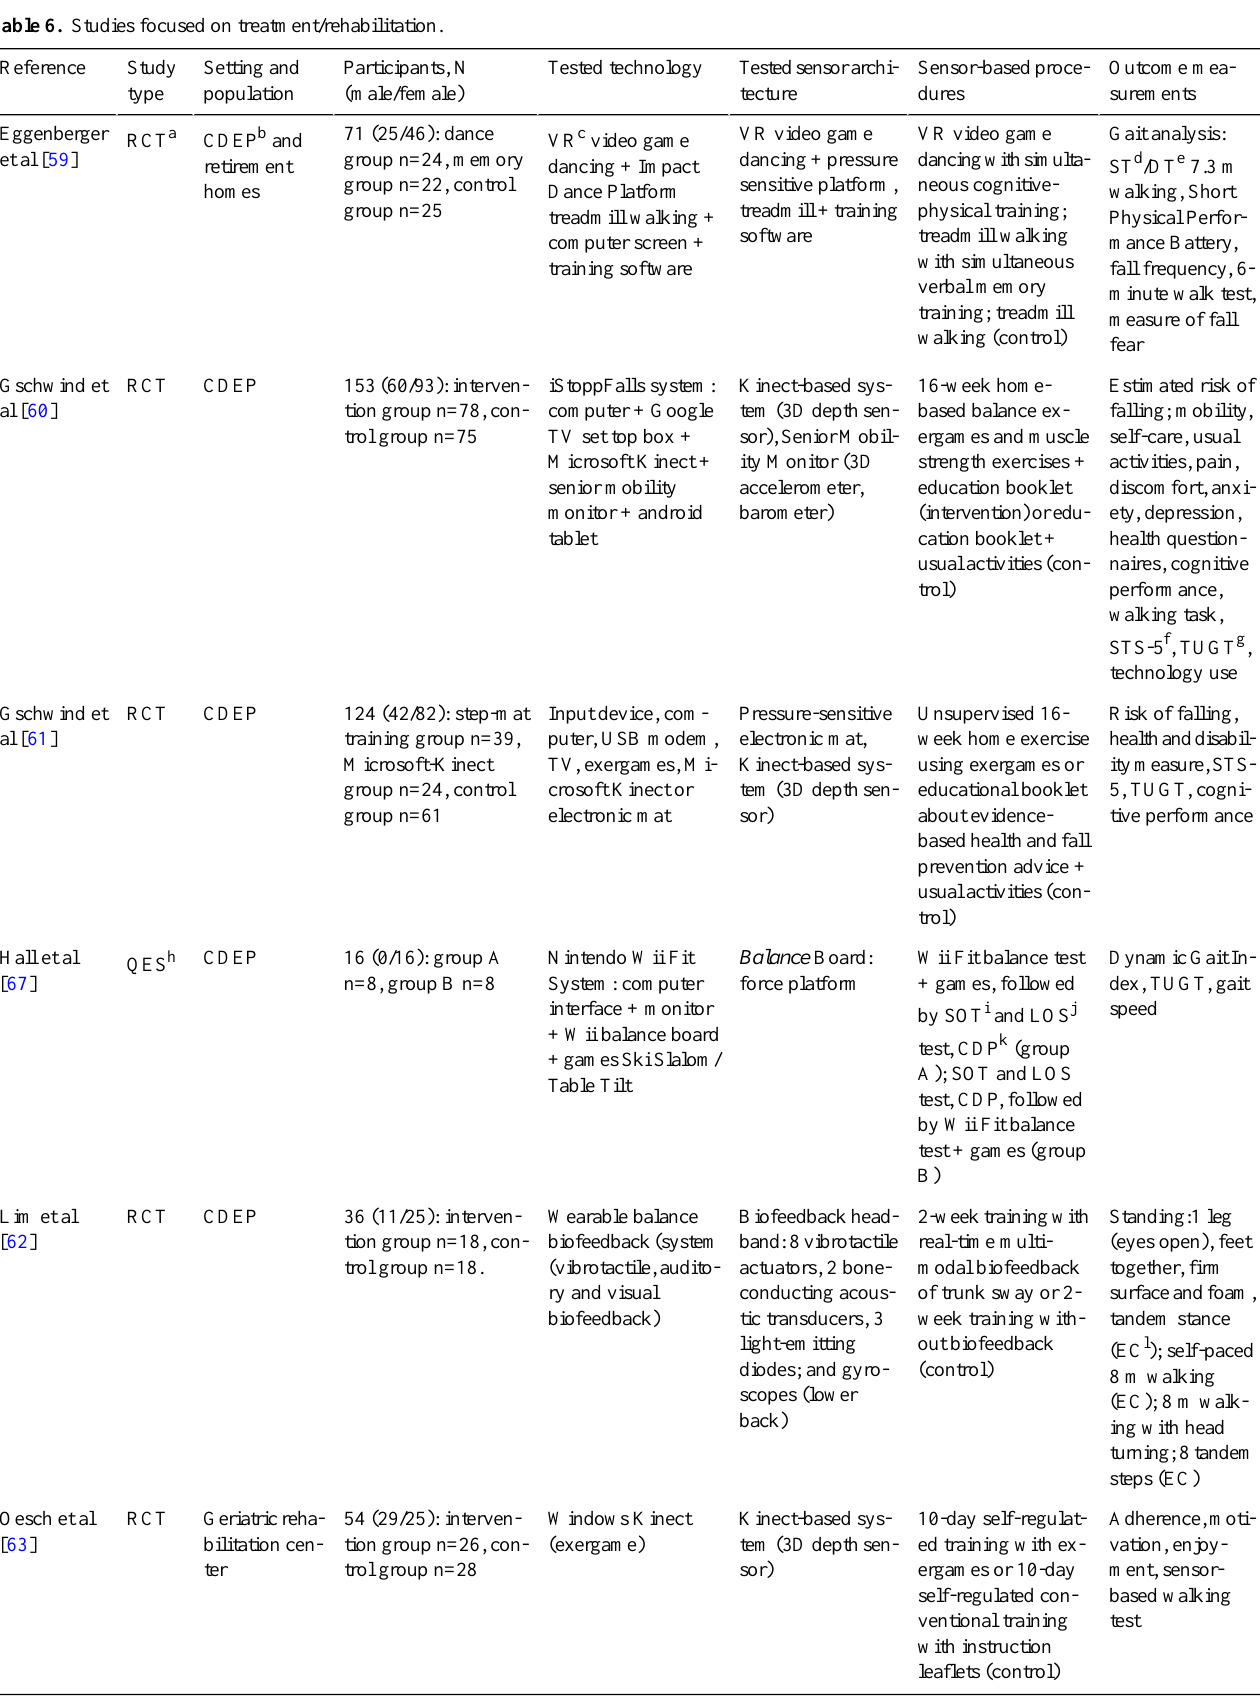
Table 6. Studies focused on